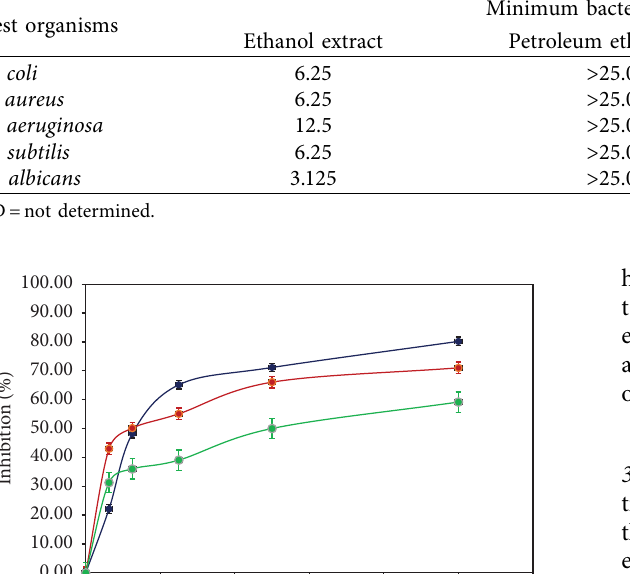
Table 5: MBCs values of C. nioroense extracts and reference drugs concentrations against test organisms. Test organisms